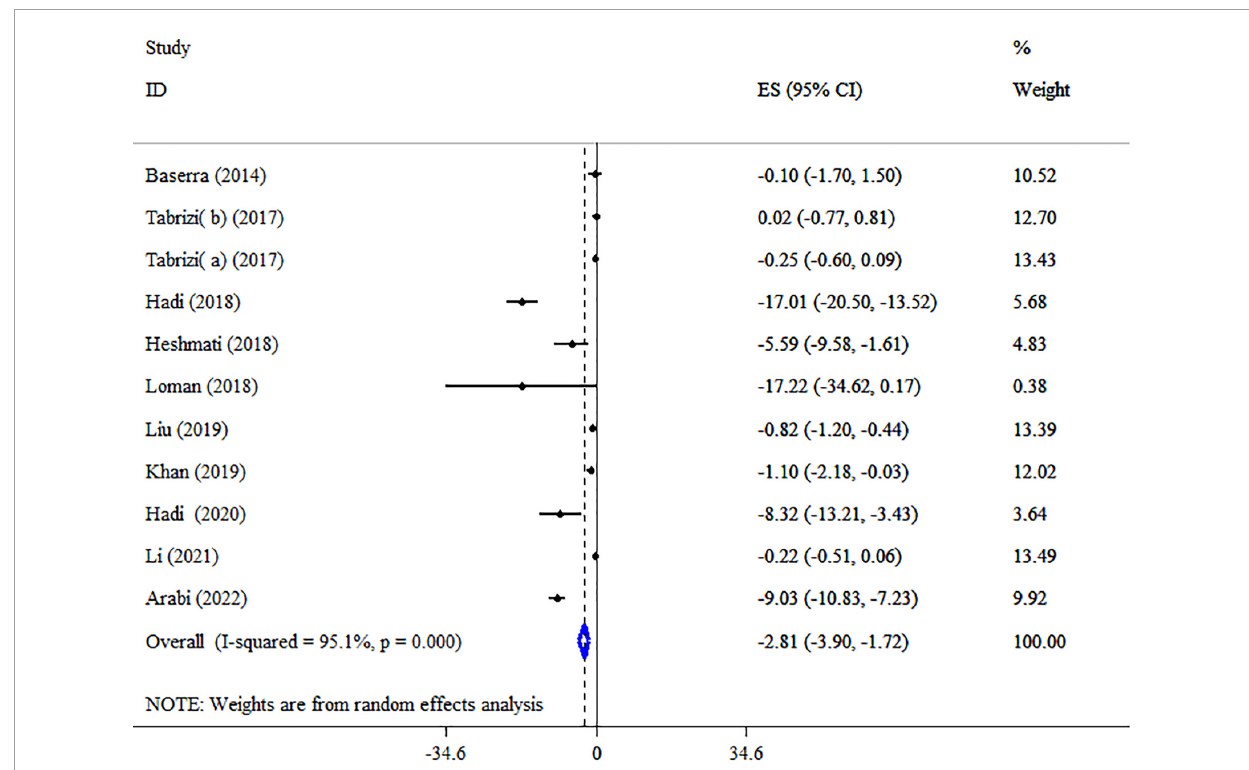
FIGURE5 Forest plot detailing mean difference and 95% confidence intervals (CIs), the impacts of synbiotic supplementation on LDL-C levels.